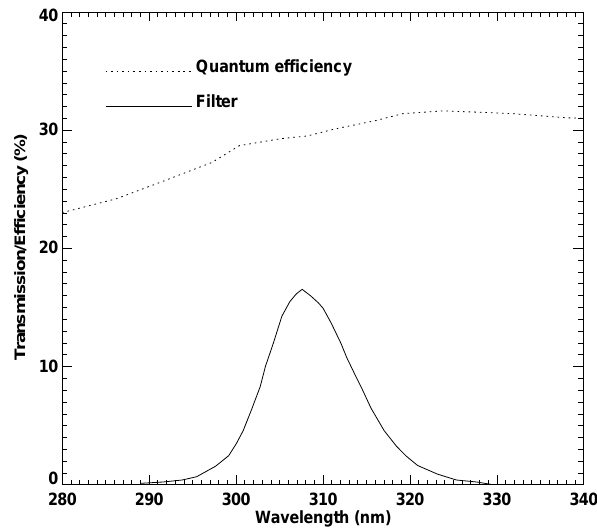
Fig. 2. The Melles Grioot 310PB10 UV narrowband filter transmis- FIGURE 2. The Melles-Grioot 310PB10 UV narrowband filter transmission and the Hamamatsu CCD sion and the Hamamatsu CCD quantum efficiency as a function of quantum efficiency as a function of wavelength.